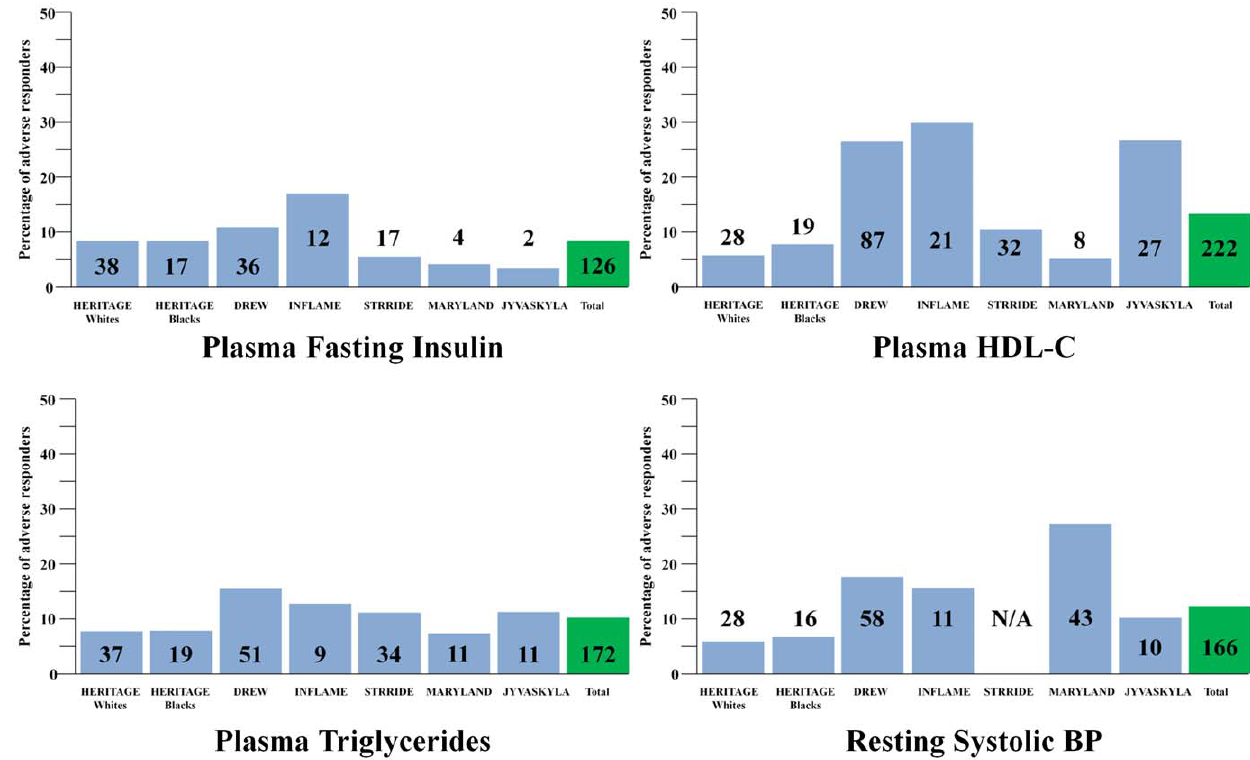
Figure 2. Percentages of adverse responders for each risk factor trait by study, with number of adverse responder subjects in each bar.